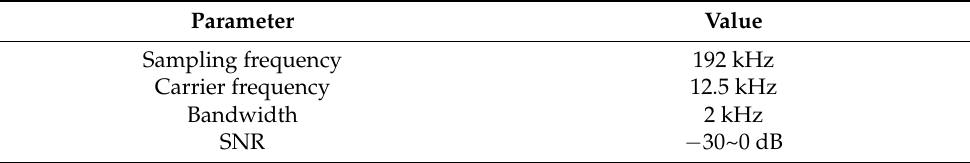
Table 1. Simulation parameters. Parameter